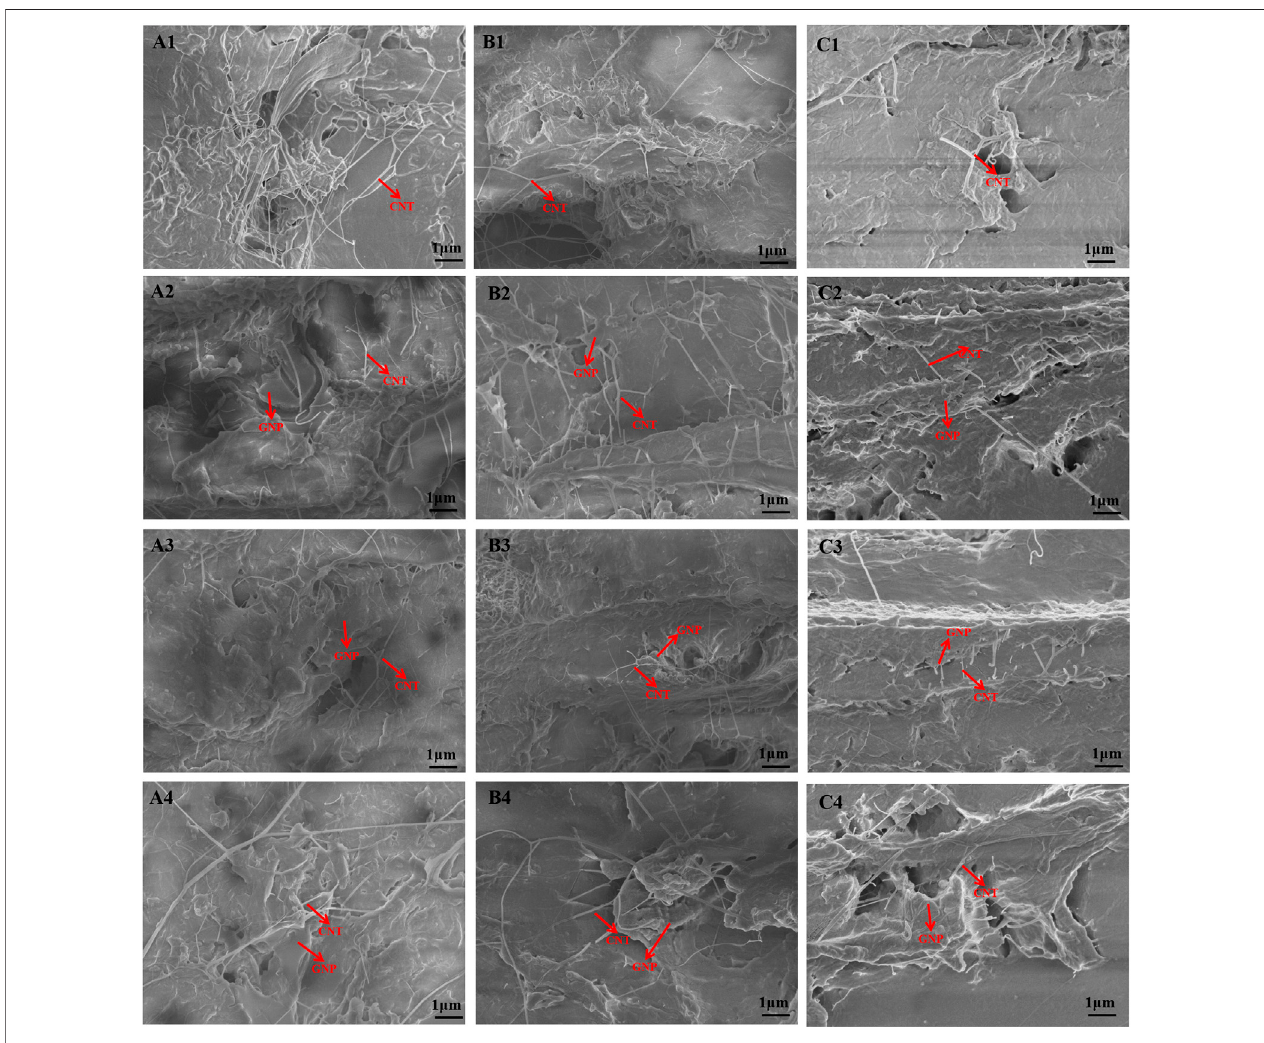
FIGURE 4 | SEM of the fracture surfaces for epoxy composites with different fi llers, (A1) CNT(SSA165)0.8/EP, (A2) CNT(SSA165) 0.7 GNP 0.1 /EP, (A3)